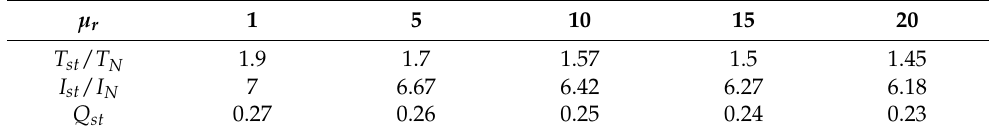
Table 2. Motor starting performance for different MSWs.